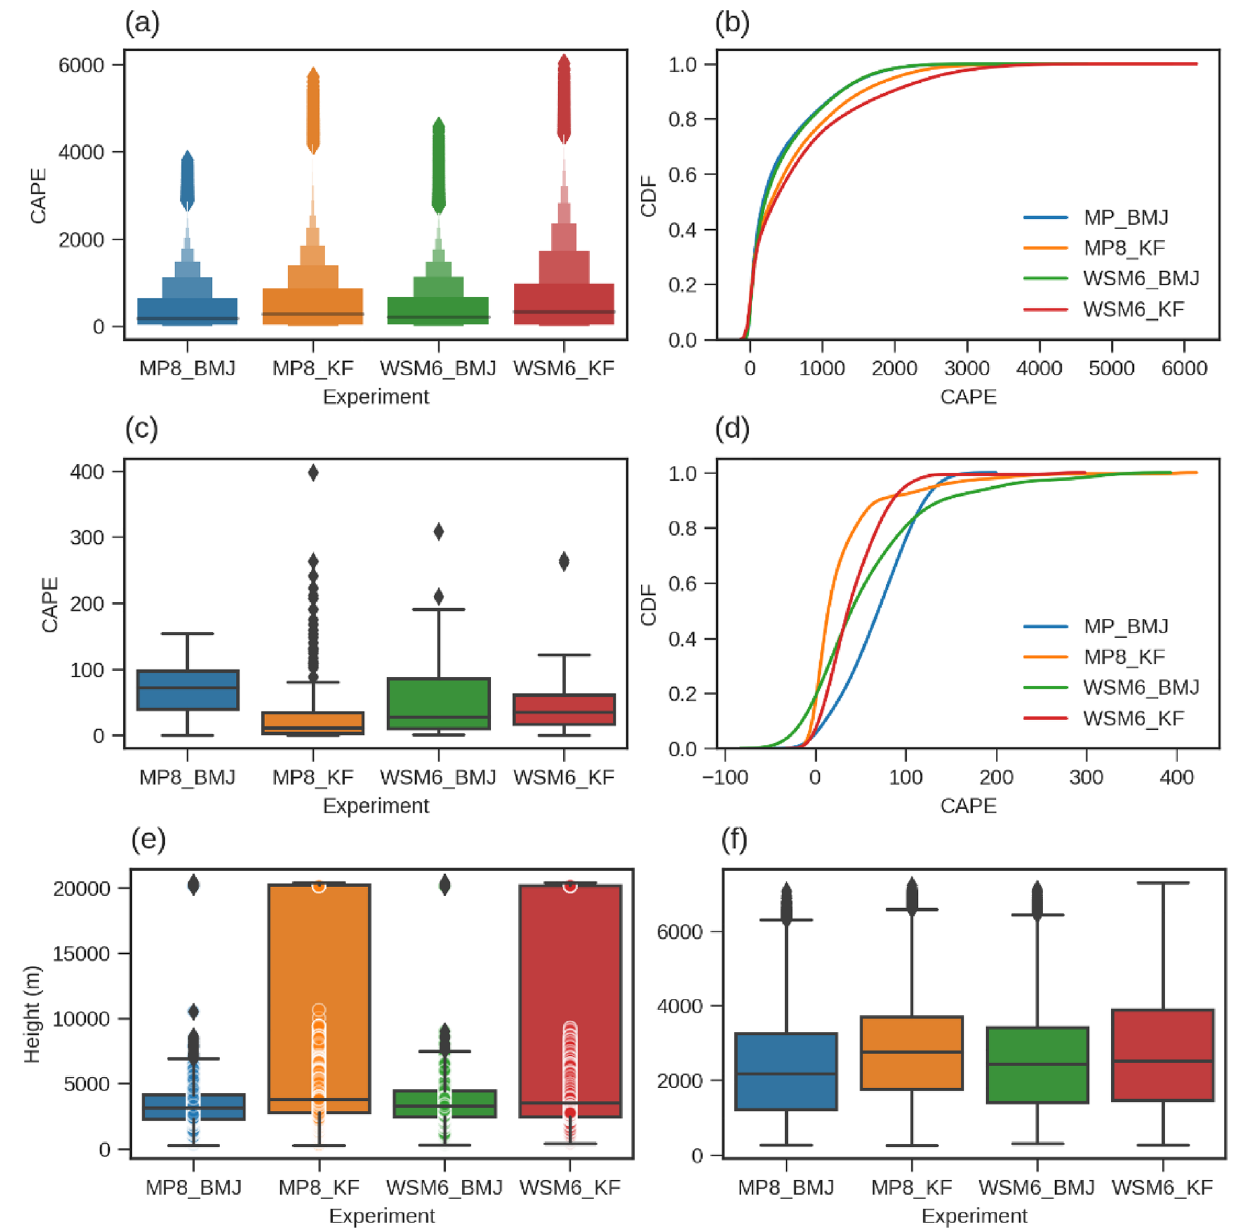
Figure 8. The maximum available CAPE for each gridpoint over d03, subsetted with d02, for MP8_BMJ, MP8_ KF, WSM6_BMJ, and WSM6_KF ( a – d ). ( a ) Shows maximum CAPE over all vertical levels, for each gridpoint and timesteps. ( b ) Shows CDF for the values shown in ( a ). ( c ) Shows shows maximum CAPE at 550 hPa vertical level, for each gridpoint and timesteps. ( d ) Shows CDF for the values shown in ( c ). ( e ) Shows LFC and ( f ) shows LFL over each gridpoint and each timestep for these